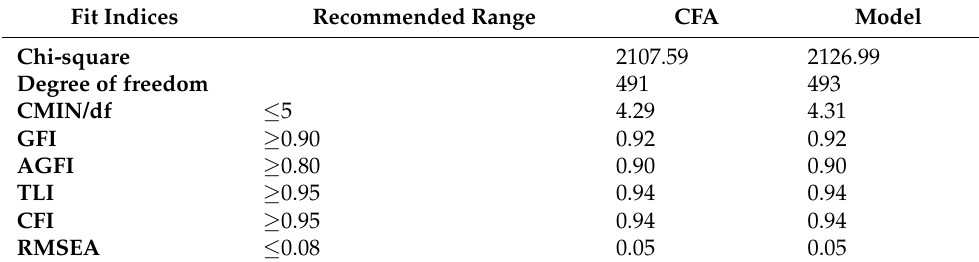
Table A6. Model fit indices recorded in the current study.